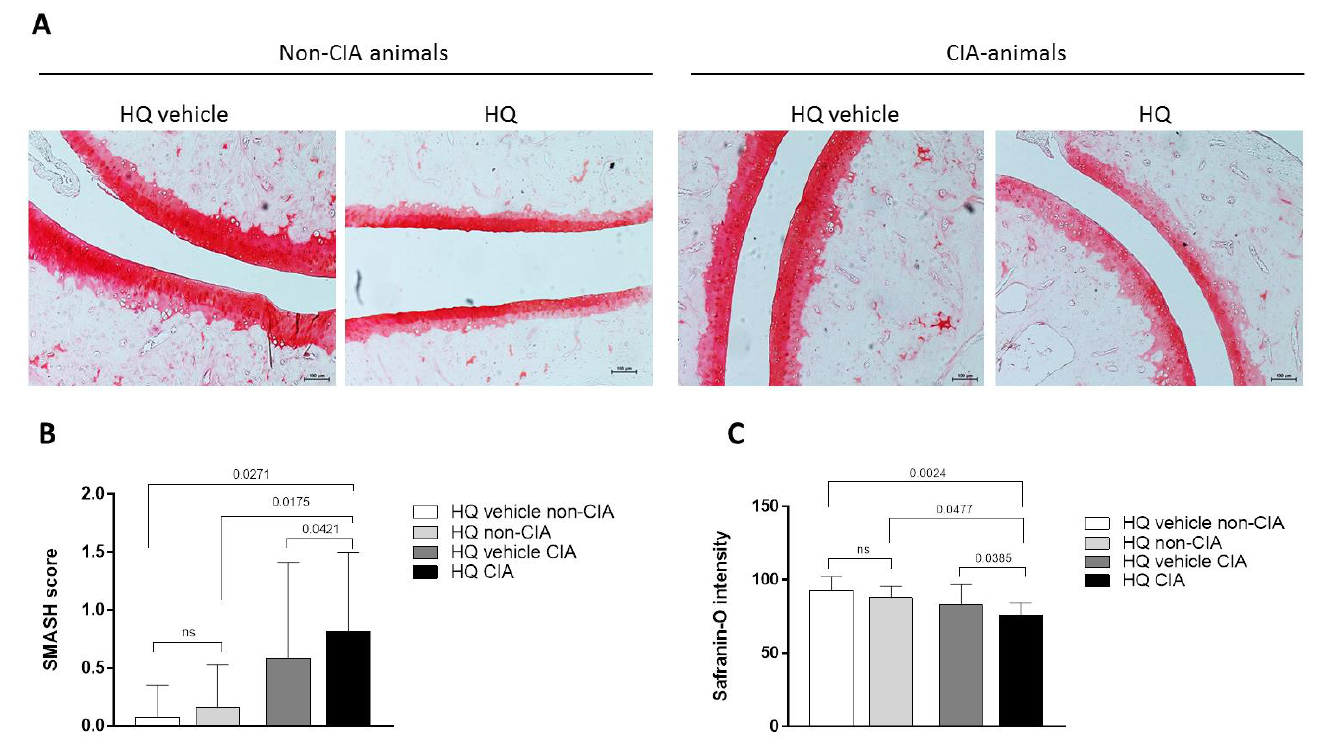
Figure 1. In vivo HQ exposure exacerbates cartilage damage in an experimental model of inflamma- tory arthritis. Exposure to HQ, by nebulisation, during 35 consecutive days, increased the loss of proteoglycan in the articular cartilage of the paw joints of CIA-exposed animals ( A – C ), quantified by using the SMASH scoring system. 10 × magnification Data represented mean ± SEM from four independent experiments and were analysed by one-way ANOVA.